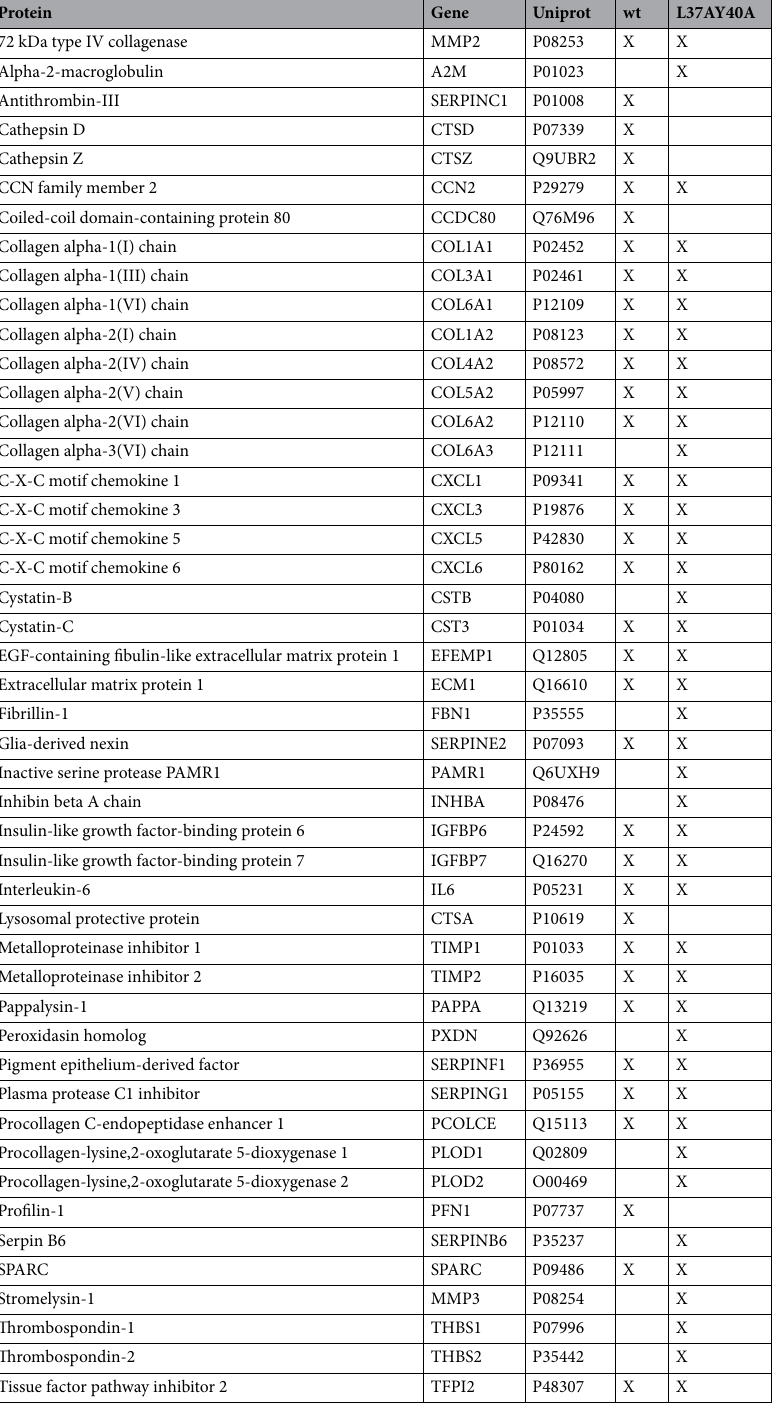
Table 1. ECM-associated proteins present at higher levels in conditioned media from HCASMC exposed to wt or L37AY40A AN compared to cells without AN exposure. A full list of all regulated proteins is available in Supplementary Data